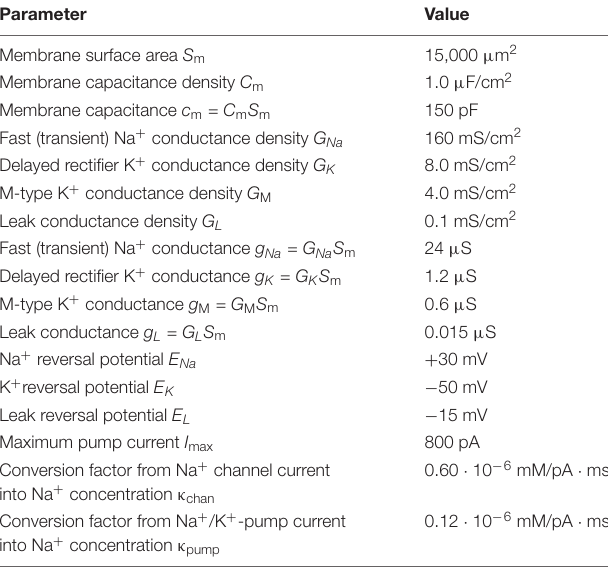
TABLE 2 | T cell model